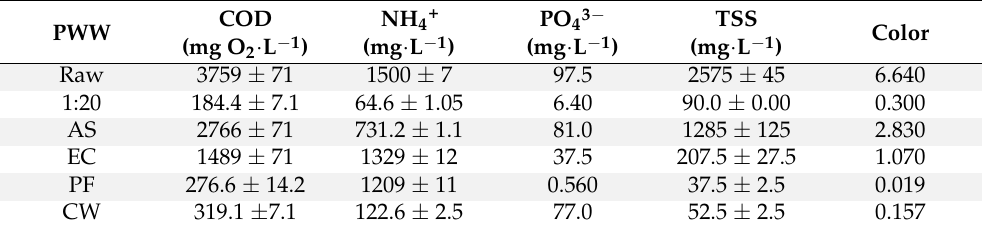
Table 3. Composition of the piggery wastewater (PWW) after the different pretreatment method- ologies (EC—electrocoagulation; AS—ammonia stripping; PF—photo-Fenton; CW—constructed wetland) compared to raw PWW and diluted 1:20, in terms of chemical oxygen demand (COD), ammonia nitrogen (NH 4+ ), phosphate (PO 43 − ), and color given by the absorbance at 540 nm. The pH was adjusted to 7 in all media before microalga